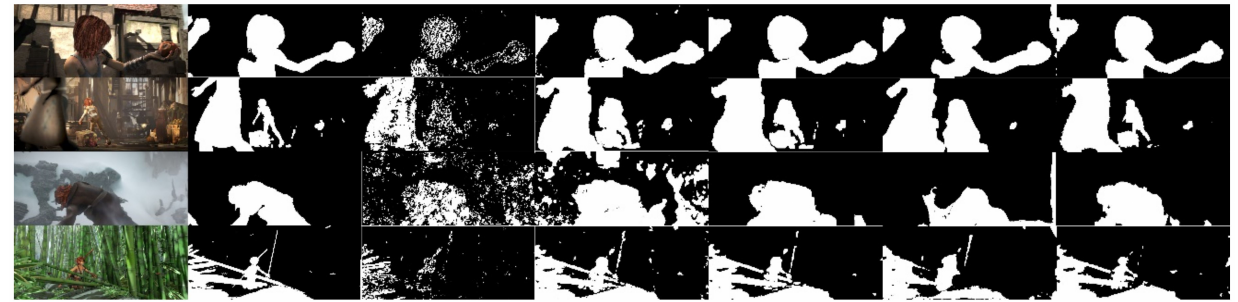
Figure 5. The MPI image sequence motion foreground extraction results, from top to bottom, are alley, market, ambush, and bamboo image sequence, and from left to right are the current frame image, the real motion foreground target area, LK, HS pyramid, Black and Anandan (B&A), Brox, and our motion extraction res